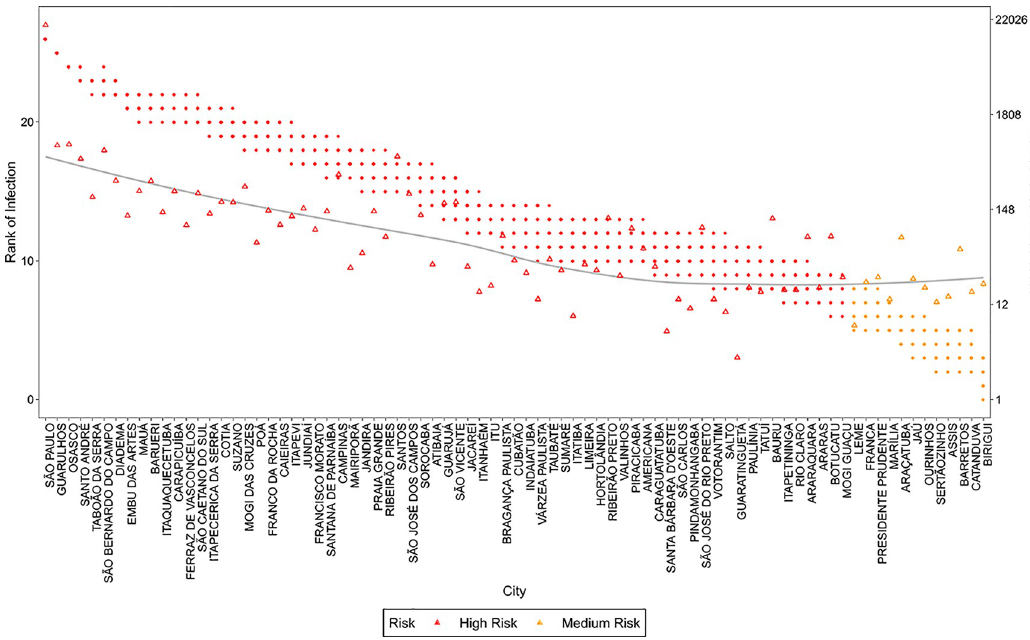
Fig 14. Rank of infection and number of confirmed COVID19 cases for S ã o Paulo state. The points refer to ranks estimated for different values of s , the triangles refer to the official number of confirmed COVID19 cases registered on the 1 st of May 2020 for each city in the state of S ã o Paulo. The line is a smooth approximation of the confirmed cases (triangles). The colors refer to the risk evaluated by k-means clustering of the ranks attributed by the simulated models.